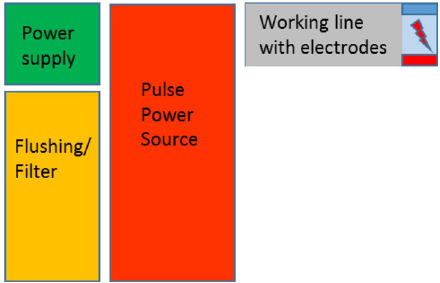
Fig. 12 Concept of a hand-operated tool for concrete removal and view of the working electrodes set on the concrete surface Fig. 13 Basic structure of the EIT